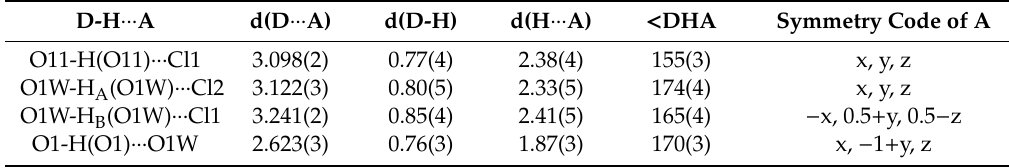
Table 4. Hydrogen bonding interactions (Å, deg) in the crystal structure of [CdCl 2 (phpaoH) 2 ] · H 2 O ( 1 · H 2 O).